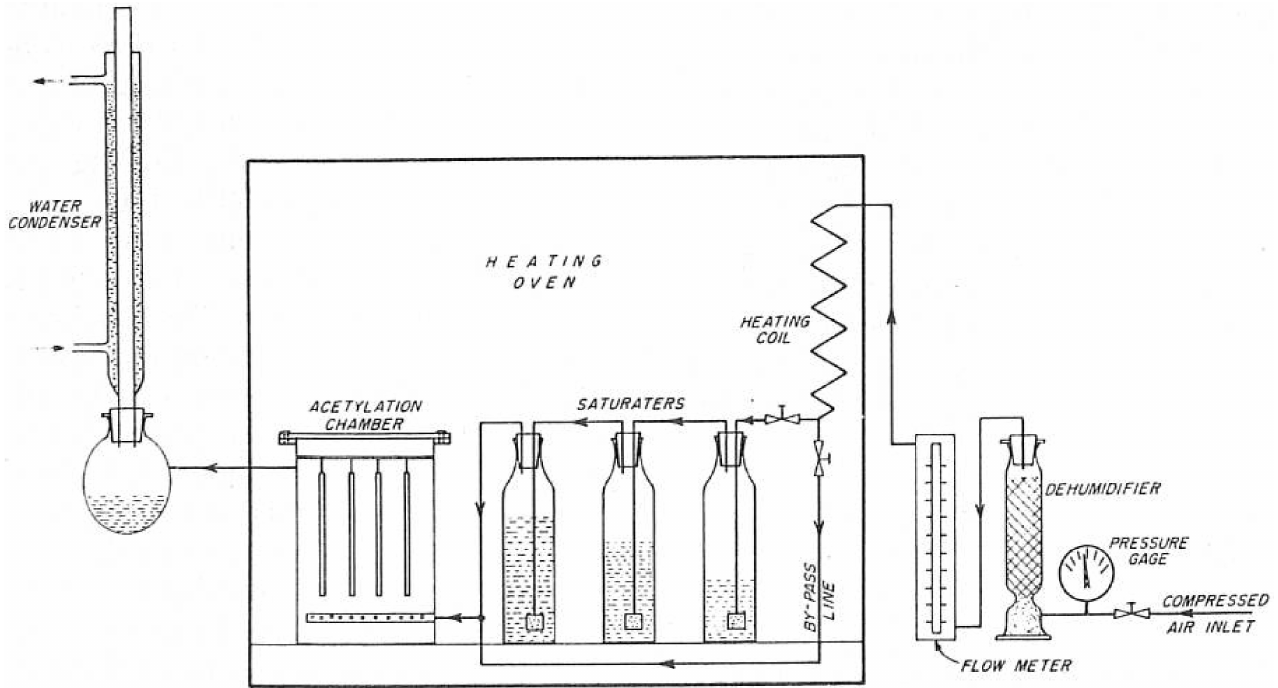
Figure 13. Equipment for uncatalyzed vapor phase acetylation of 1/8 inch hardboard